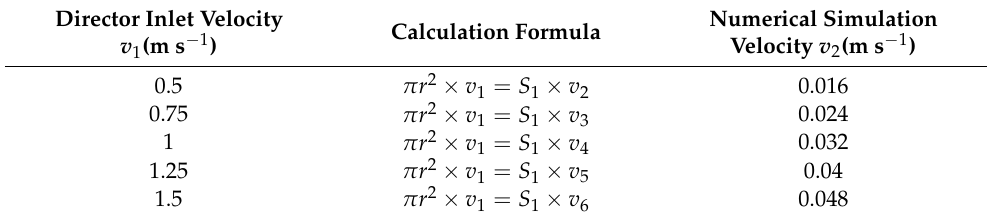
Table 4. Relationship between the fed water velocity from the main pipe inlet and the velocity of the water